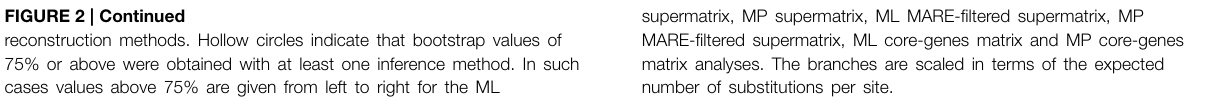
matrix analyses. The branches are scaled in terms of the expected number of substitutions per